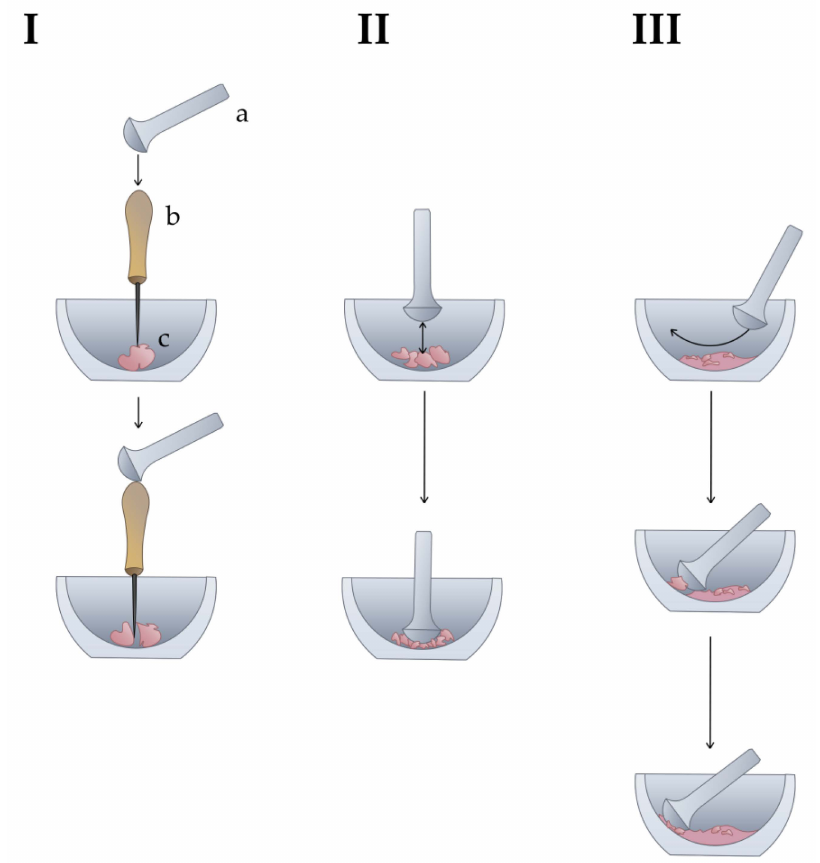
Figure 1. The technique of cartilage homogenization by mortar and pestle. The liquid nitrogen is not depicted to simplify the illustration. I : Fragmentation of a large piece of cartilage with an awl. a—pestle, b—awl, c—cartilage. II : Crushing of small fragments of cartilage. III : Crushing of the remaining small